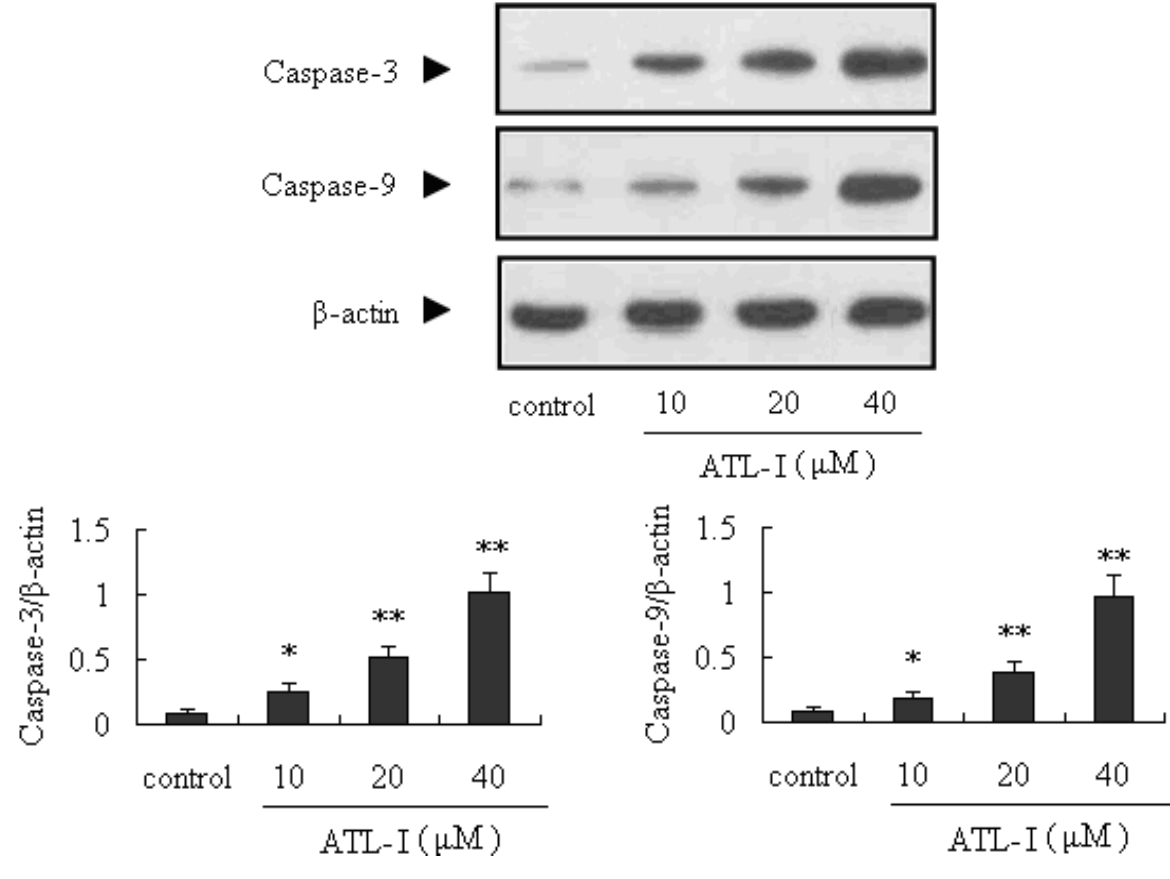
Figure 4. Effect of ATL-I on caspase-3 and caspase-9 expressions in A 549 cells. Cells were treated with ATL-I at the concentrations of 10, 20, and 40 μ M for 48 hours, and the whole cell lysates were determined by western blot analysis using antibodies for caspase-3 and caspase-9 as indicated. All data were expressed as mean ± SEM (n = 3), * p < 0.05, ** p < 0.01, vs.